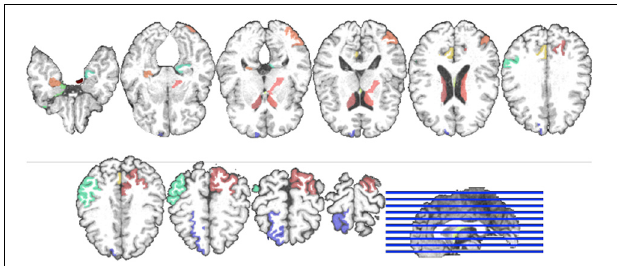
FIGURE 6 | Visualization of the selected ROIs by the proposed method. Different colors denote different brain